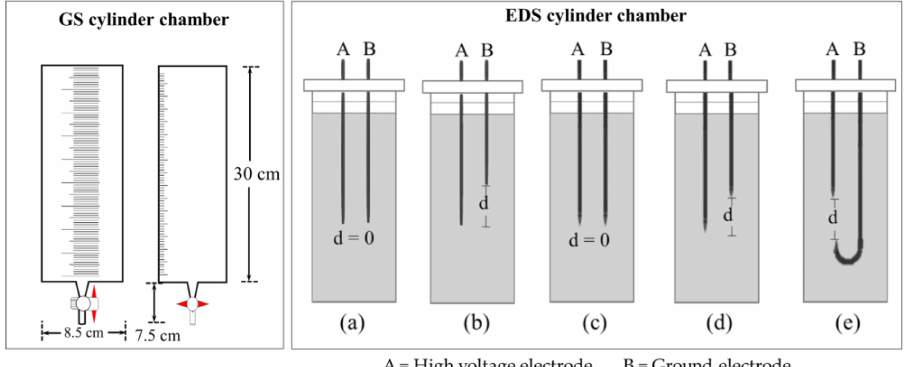
Figure 8. Schematic of configurations of electrode arrangement (A = High voltage electrode and B = Ground electrode): ( a ) bar electrodes at the same level (d = 0); ( b ) bar electrodes at different levels with electrode distance (d); ( c ) point electrodes at the same level (d = 0); ( d ) point electrodes at different levels with electrode distance (d); and ( e ) point-to-point electrodes with electrode distance